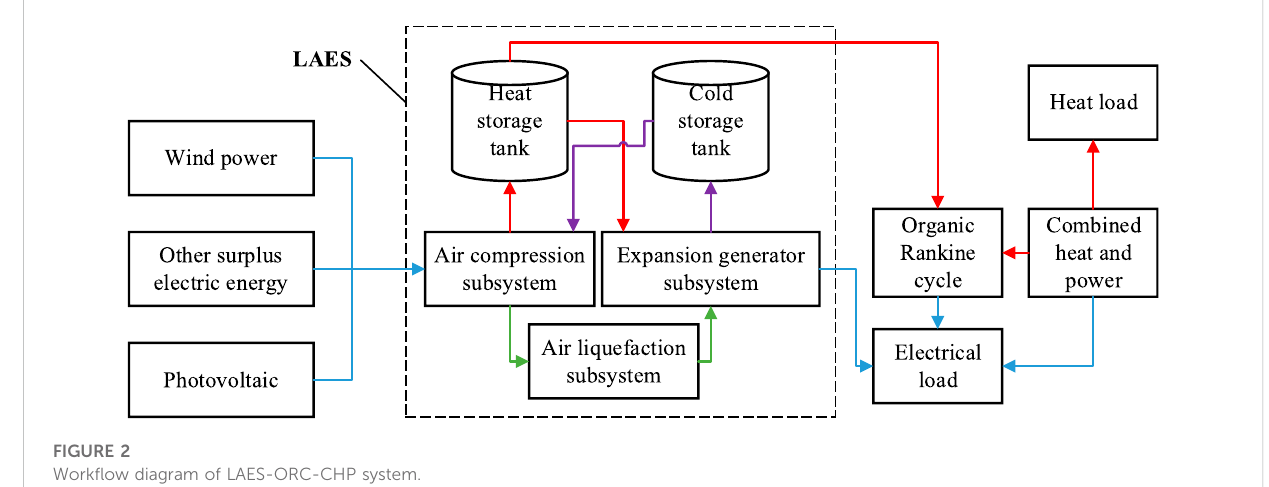
FIGURE 2 Work fl ow diagram of LAES-ORC-CHP